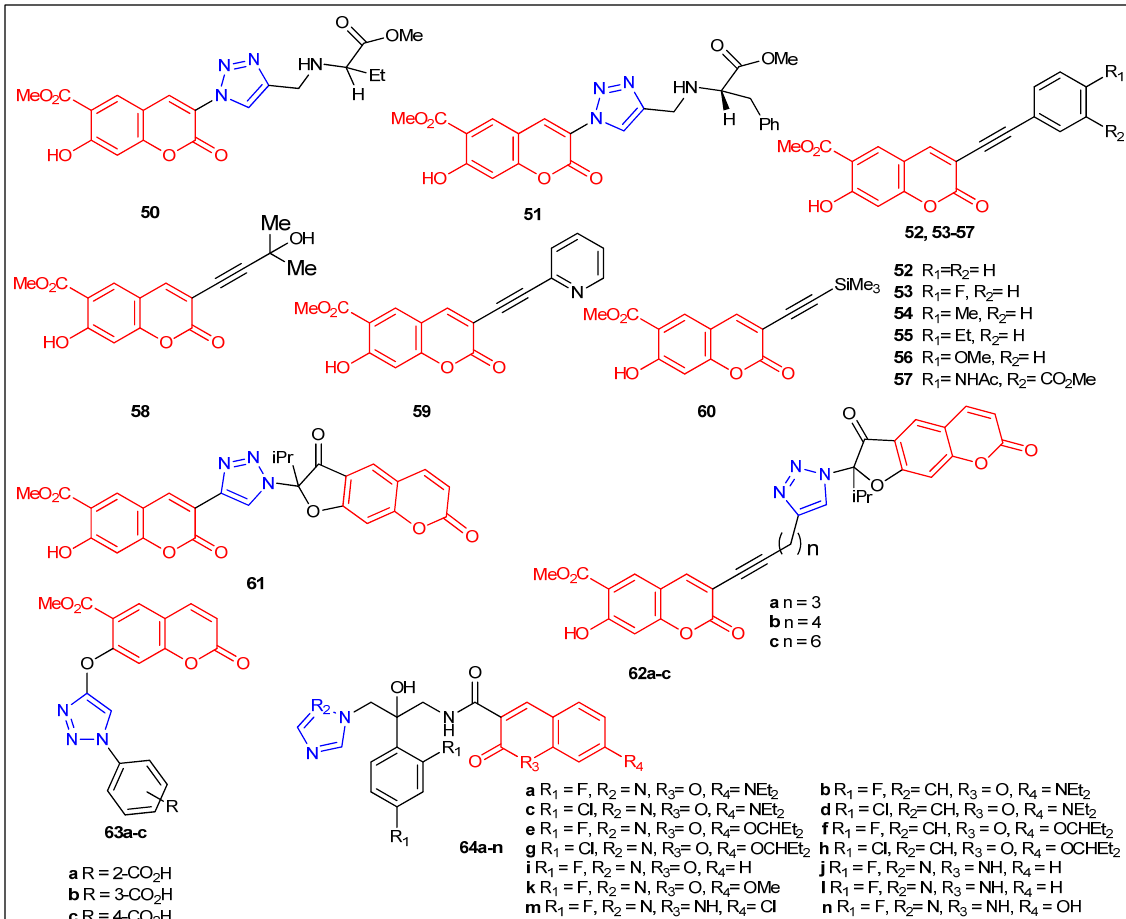
Figure 7. Structures of the reported coumarin triazole derivatives from 2018 – 2019 . From copper(I)-catalyzed click reaction between various substituted terminal al- kynes and arylazides, coumarin-based 1,4-disubstituted 1,2,3-triazoles [ 65a – l ] (Figure 8) were synthesized through microwave irradiation [54]. All the prepared compounds were screened for their antibacterial potential against S. aureus , E. coli , B. subtilis , and K. pneu- monia at concentrations of 10 μ g mL − 1 and 20 μ g mL − 1 , respectively. Amongst all the newly were highly active toward E. coli because of the presence of the methoxy group in the triazole ring. Furthermore, compounds 65k (26 mm) and 65l (27 mm) have demonstrated nearly similar activity to that of the standard drug gatifloxacin (30 mm). Synthesized com- pounds [ 65a – l ] were also screened for their in vitro antifungal potential through three fungal organisms such as A. flavus , F. sporum , and A. niger , at a concentration of 50 μ g mL − 1 , and the results with ZoI range from 10.3mm to 18.8mm and have been mostly com- parable to the standard drug Clotrimazole (Table 5). It was noticed that among all the prepared compounds, 65a , 65b , 65c , 65j , 65k , and 65l exhibited good activity through three pathogenic fungi due to the presence of fluorine and methoxy groups on coumarin and triazole rings. The remaining compounds displayed comparable activity to Clotrima- zole as a standard drug. In this series of compounds, the chloro and bromo halogens, along with the methoxy substitutions on both phenyl rings, seem to be important for ob- taining comparable antimicrobial activity. Singh et al. reported the synthesis and antimi- crobial evaluation of a series of new coumarin-tagged β -lactam triazole hybrids [ 66a – o ] [55] (Figure 8). Antimicrobial activity studies concluded that compounds containing chloro and methyl groups ( 66c and 66i ) exhibited moderate antimicrobial activity toward